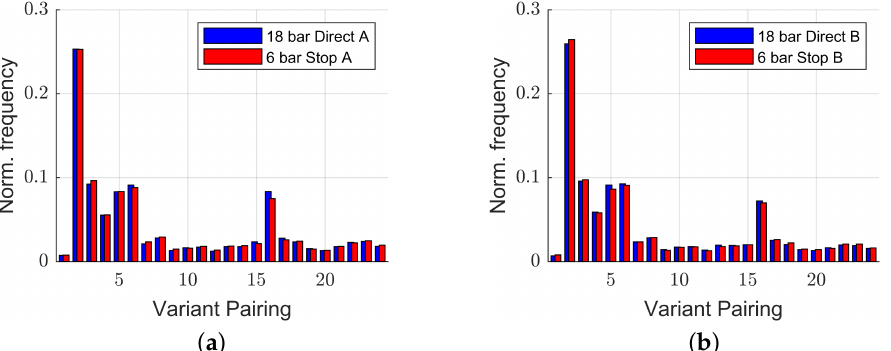
Figure 7. Variant pairing after Morito [28] for 18 bar Direct and 6 bar Stop for ( a ) 20MnCr5 (A) and ( b ) 17NiCrMo6-4